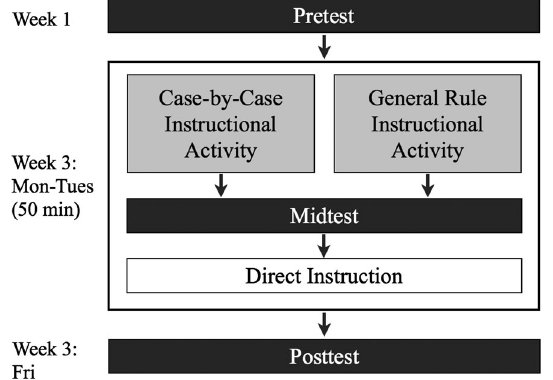
FIG. 5. Direction posttest question and magnitude posttest question asking students to use the equipotential lines to predict the electric field. FIG. 6. The research design